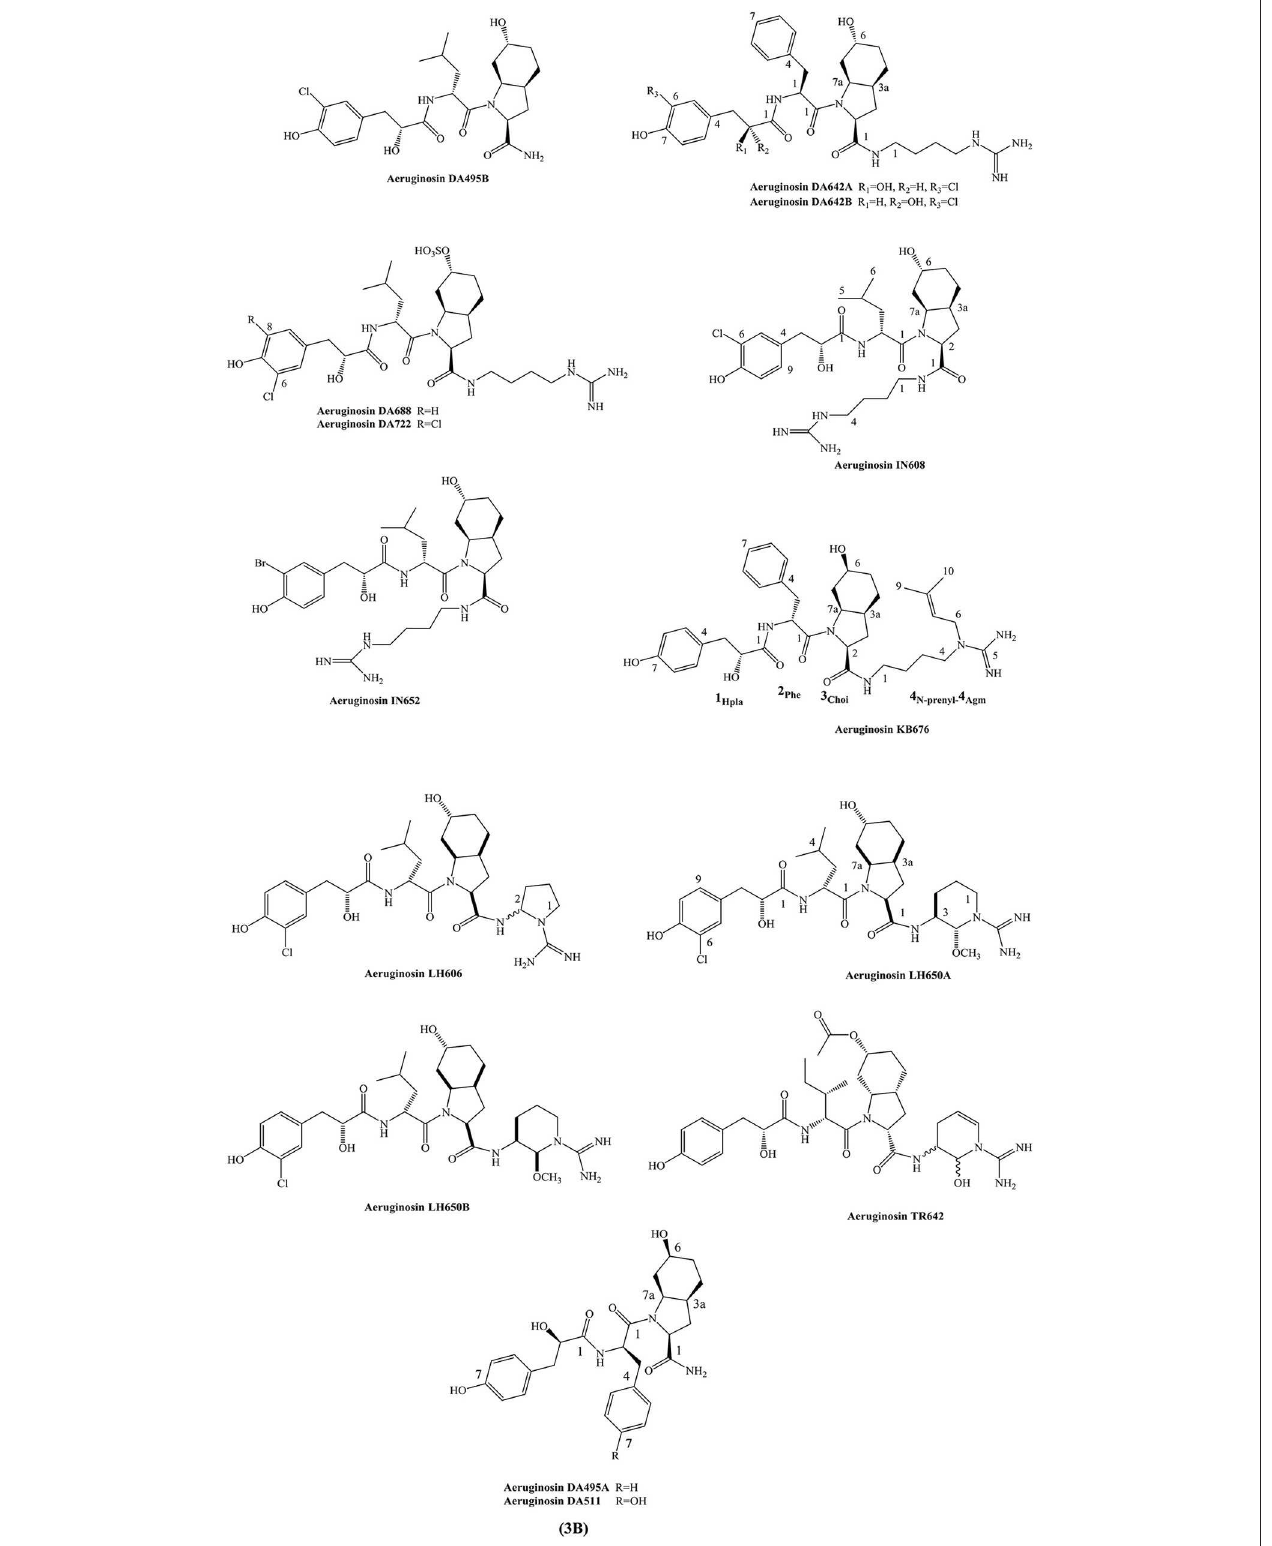
FIGURE 3 | Chemical structures of bioactive molecules from Microcystis . (A) Micropeptins, (B) Aeruginosins.